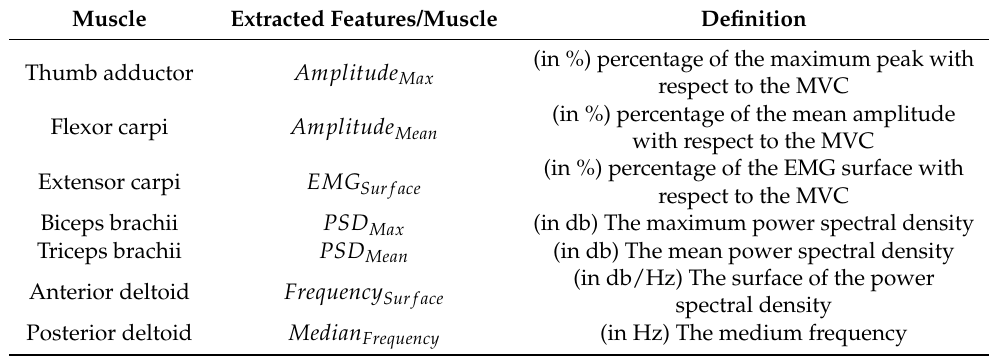
Table 1. Features extracted from